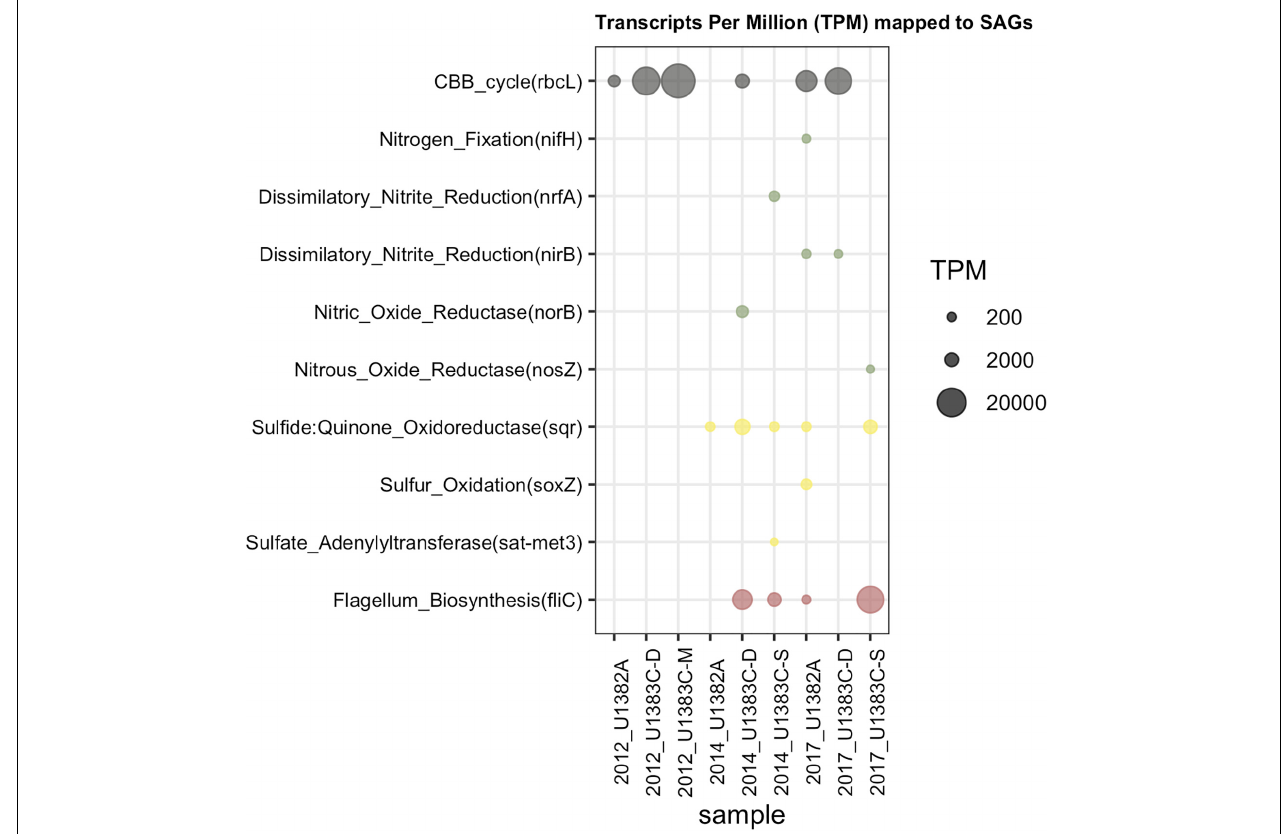
FIGURE 6 | Transcript Per Million (TPM) data after mapping metatranscriptomes from all years and horizons to the SAG library from 2017 Hole U1383C Deep. The Y Axis lists the subset of key functions (as discussed in Seyler et al., 2020; Figure 5 ) from the 2017 Hole U1383C Deep SAGs that received mapped